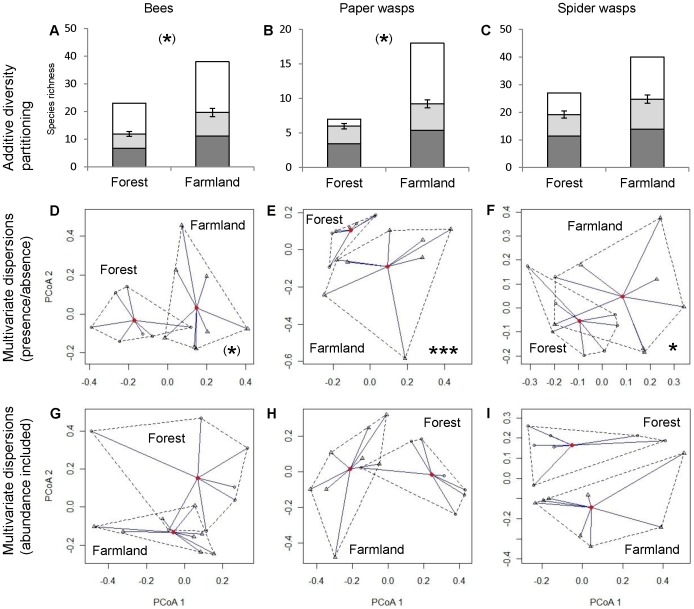
Community variation (beta diversity) of bees and wasps.(A–C) Alpha diversity (dark grey), temporal beta diversity (light grey), and spatial beta diversity (white) compared between protected forest and heterogeneous farmland based on additive diversity partitioning. Temporal beta diversity was replicated and statistically tested. Error bars show standard error of the mean. Total height of bars indicates overall (gamma) diversity within forest or farmland. (D–I) Spatial beta diversity, measured as distance to centroid (homogeneity of multivariate dispersions), was based on (D–F) Sørensen dissimilarities (presence/absence) and (G–I) Bray-Curtis dissimilarities (abundance included). Points (forest) and triangles (farmland) represent species composition of one study site. Larger distances between study sites and the mean composition of a habitat type (unbroken lines) indicate higher difference in species composition. Dashed lines connect all sites of one habitat type. Significance levels: *** p<0.001, * p<0.05, (*) p<0.1.